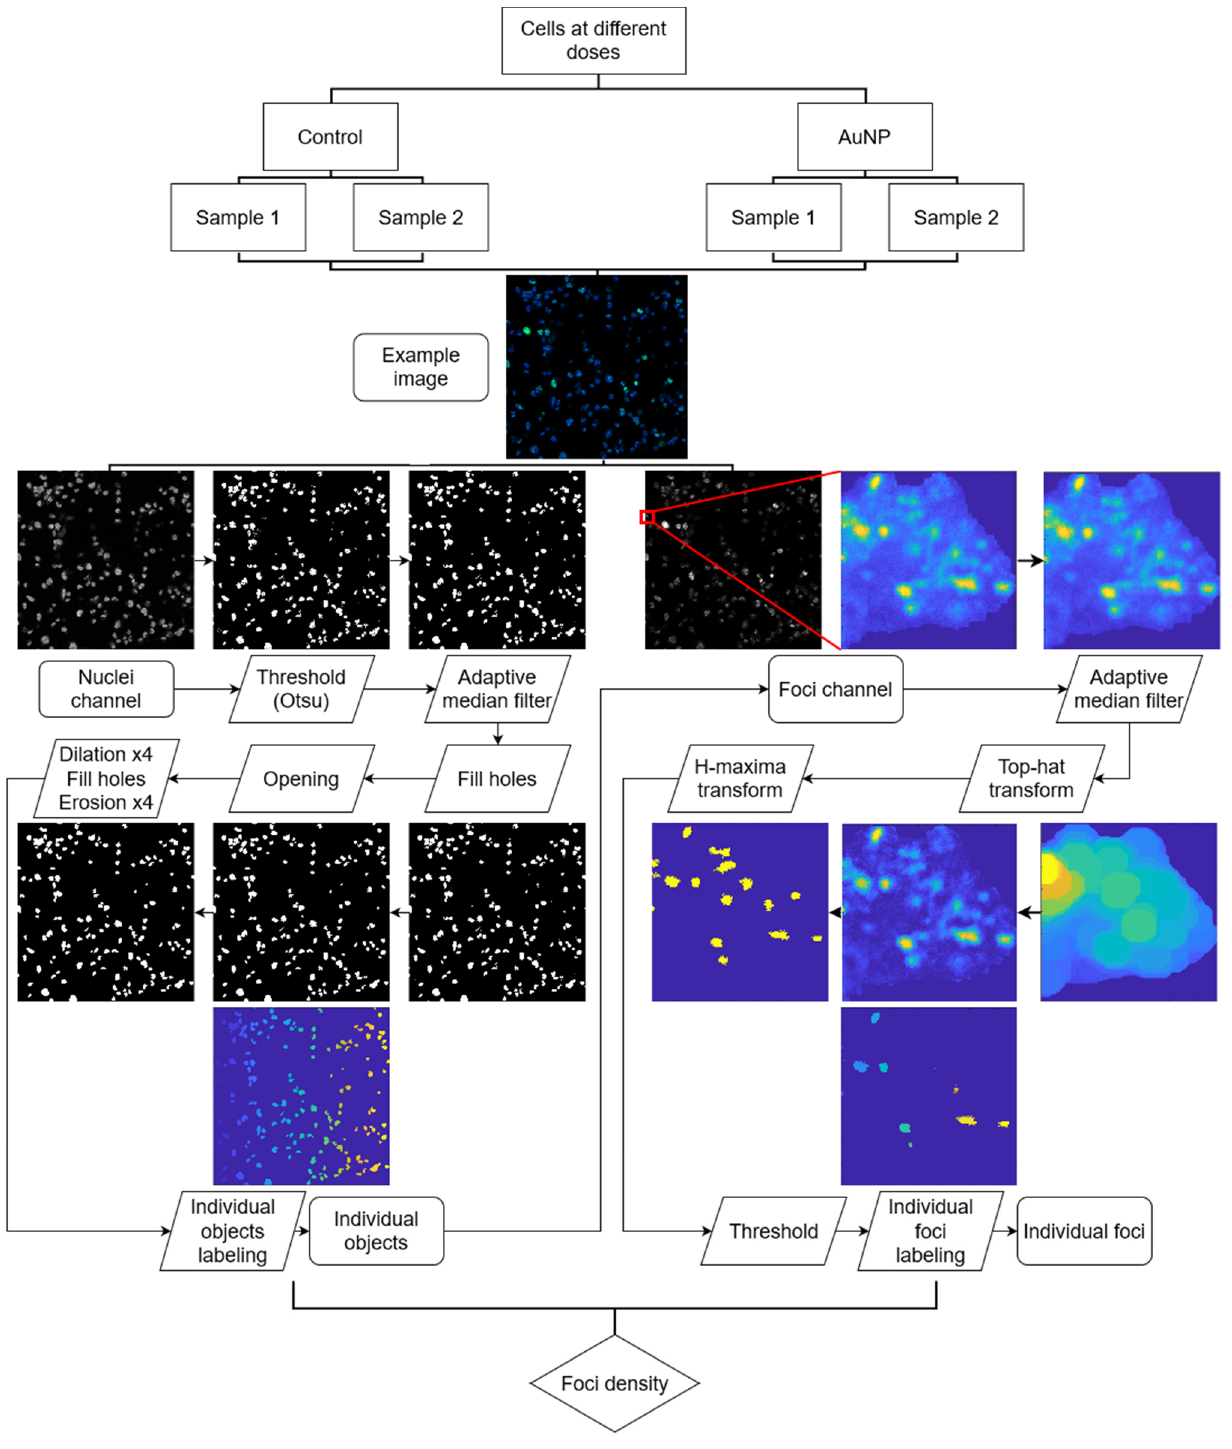
Figure 2. Workflow of the SoFoCo algorithm used for foci density quantification.